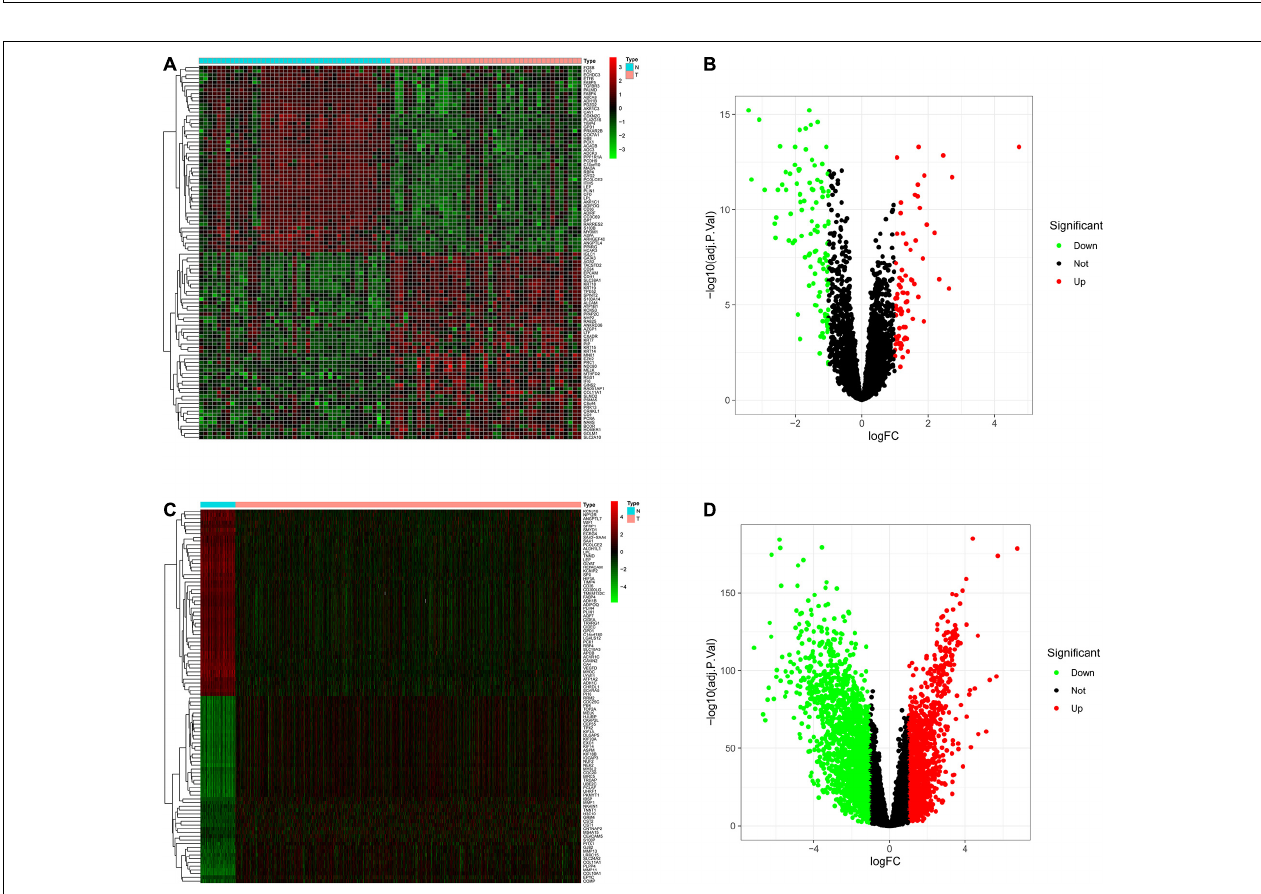
FIGURE 3 | The differentially expressed genes (DEGs) were screened. Each column of the heat map represents the sample, the row represents the gene, and each grid represents the degree of gene expression in the sample. The row of the volcano graph represents log|FC|, and the column represents − log10 (adjusted P -value), and each point is the degree of gene expression. (A) Heat plot of DEGs in the GEO. (B) Volcano plot of DEGs in the GEO. (C) Heat plot of DEGs in the TCGA. (D) Volcano plot of DEGs in the TCGA.